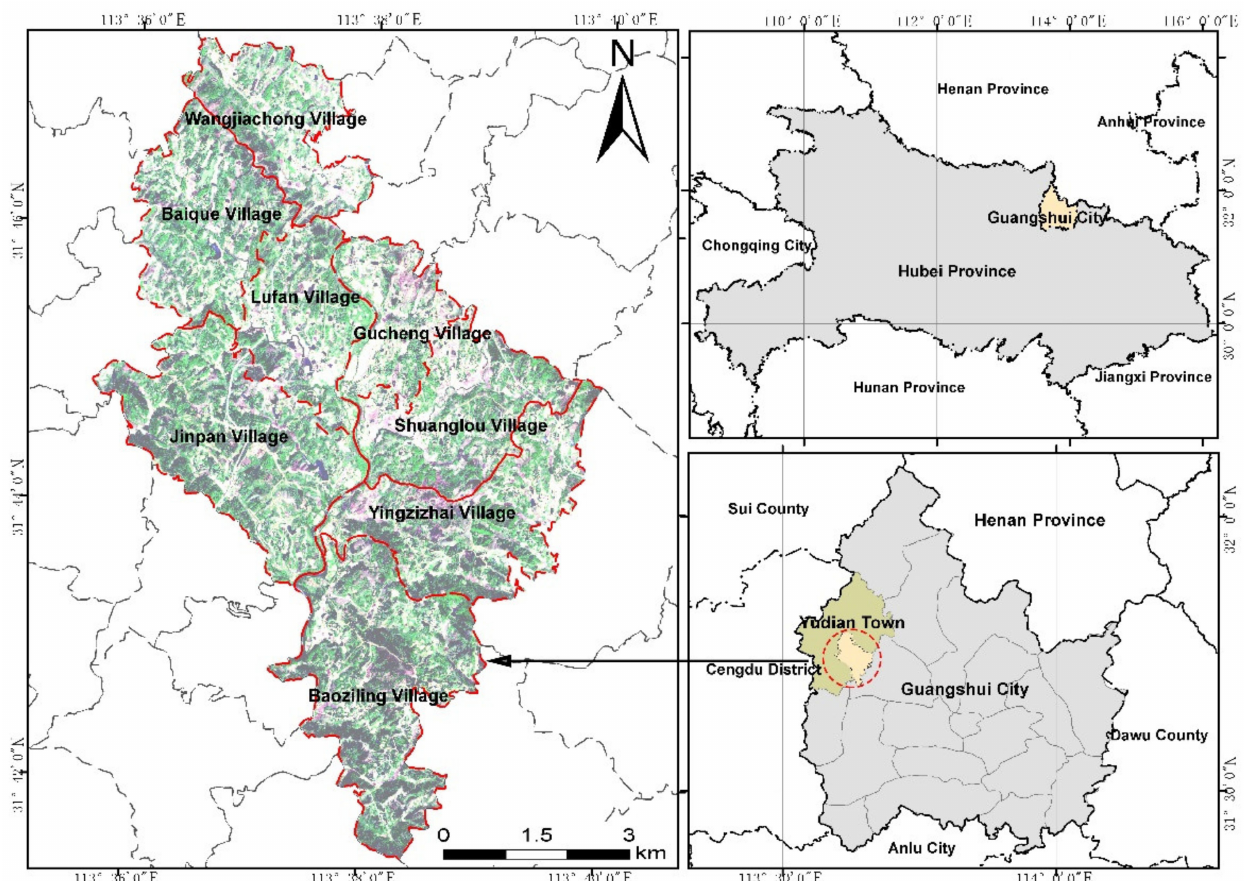
Figure 4. Location map of the study area (eight administrative